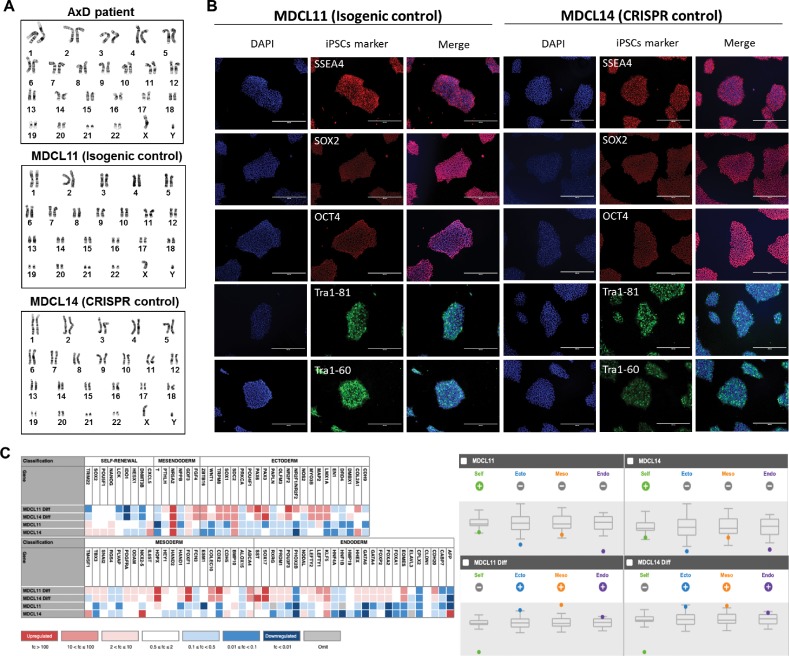
Characterization of pluripotency in AxD and isogenic control iPSCs.(A) Karyotype analysis for original AxD patient iPSCs, isogenic control (MDCL11) and CRISPR control (MDCL14) iPSCs showing normal karyotypes for all three clones. (B) Immunofluorescence staining for iPSC pluripotency markers (red/green) and DAPI (blue). Scale bars = 400 µm. (C) TaqMan hPSC Scorecard Panel that compares the gene expression profile of the generated iPSCs against nine reference lines. Heat map of the genes that are up-regulated (red), have the same expression level (white) or are down -regulated (blue) in the iPSCs. Colors correlate to the fold change in expression of the indicated gene relative to the undifferentiated or Day seven embryoid body (EB) differentiated reference set. Shown at the bottom are differentiation index plots of changes in self-renewal genes (green) and differentiation genes (blue-ectoderm, orange-mesoderm, purple-endoderm) in the 1 week EB differentiated cells (left) and undifferentiated cells (right).